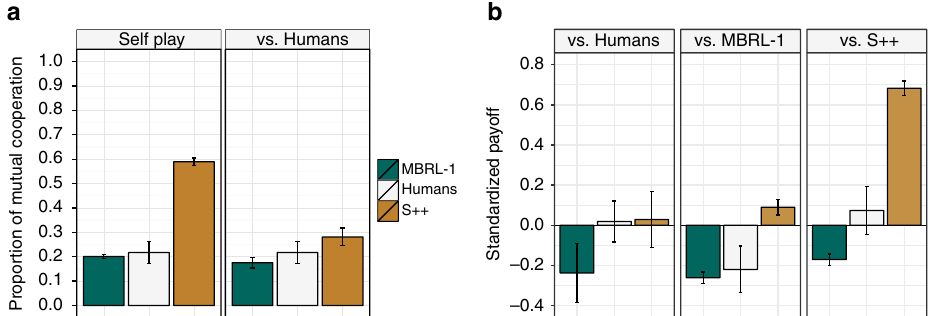
Fig. 2 Results from an initial user study. In this study, participants were paired with other people, S++, and MBRL-1 in four different repeated normal-form games. Each game consisted of 50+ rounds. a The proportion of rounds in which both players cooperated when a player was paired with a partner of like type (self-play) and with a human. b The standardized payoff, computed as the standardized z-score, obtained by each algorithm when paired with each partner type. In both plots, error bars show the standard error of the mean. These plots show that while S++ learns to cooperate with a copy of itself, it fails to consistently forge cooperative relationships with people. There were some variations across games. Details about the user study and results are provided in Supplementary Note 5